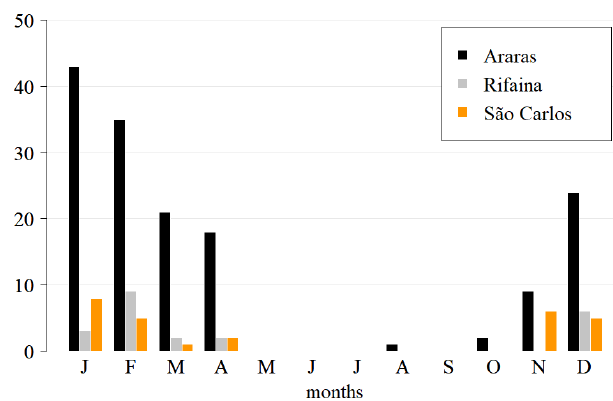
Fig 2 . Number of nests of Podium denticulatum sampled monthly in three locations at São Paulo state during 2004 –